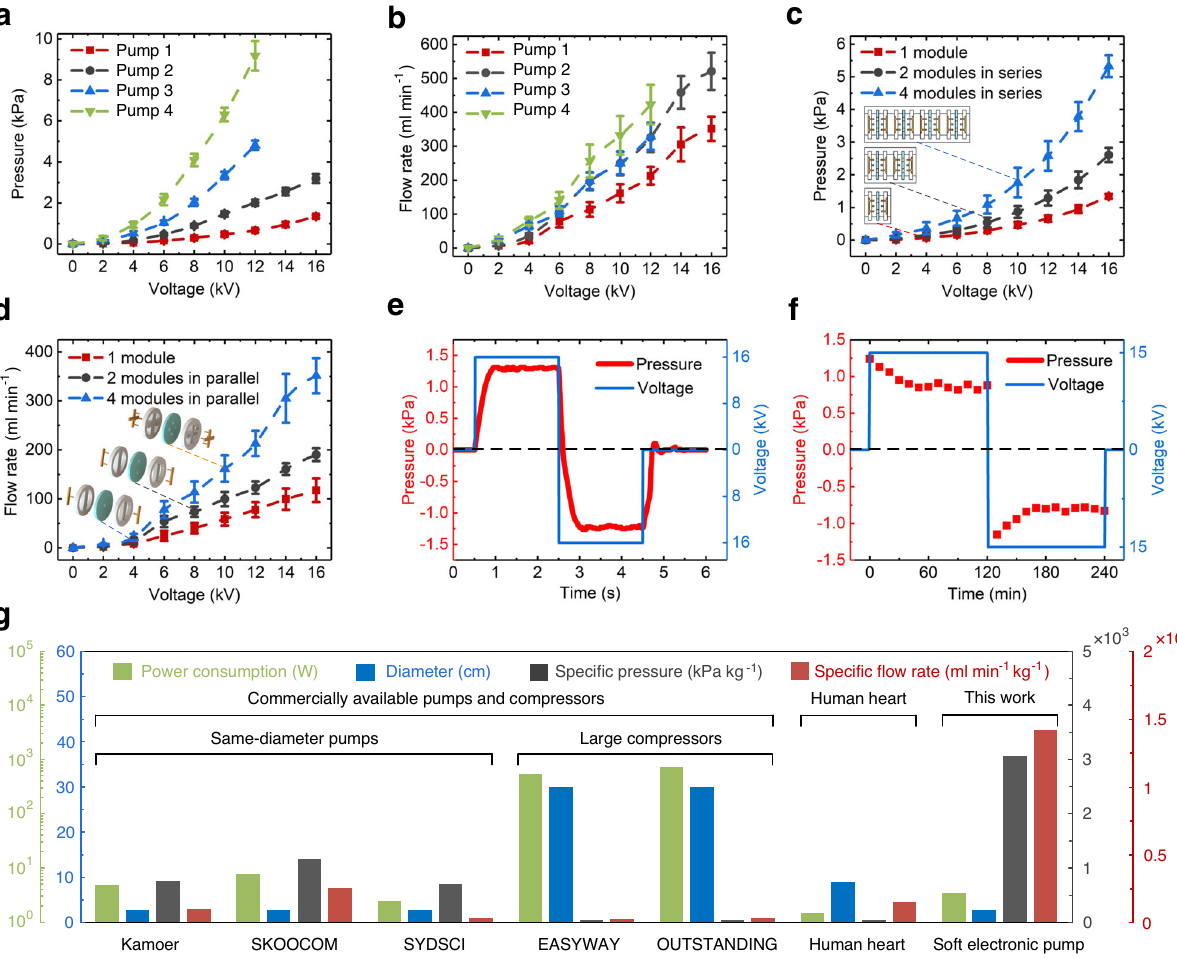
Fig. 3 Customizable pumpabilities of soft electronic pumps. a Generated pressure-voltage curve of different combinations of electrode designs and